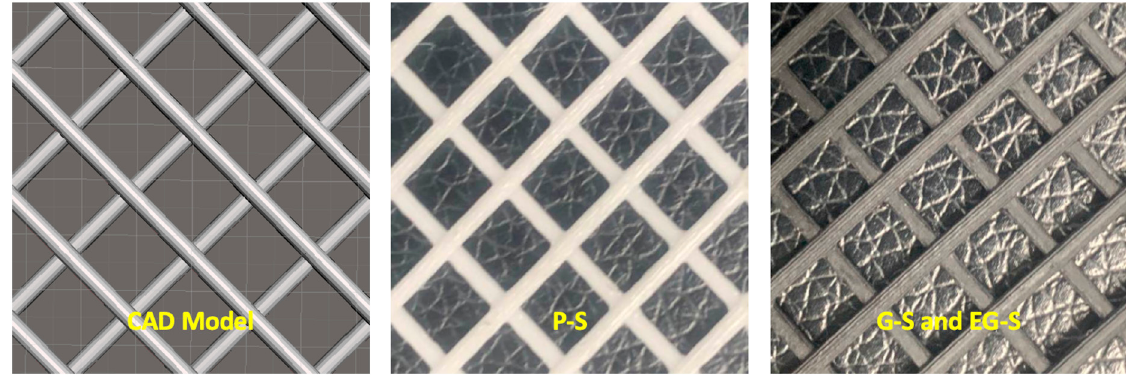
Figure 1. CAD model; 3D printed poly(lactic acid) (P-S); graphene-blended poly(lactic acid) (G-S); and electrically polarized graphene-blended poly(lactic acid) (EG-S).